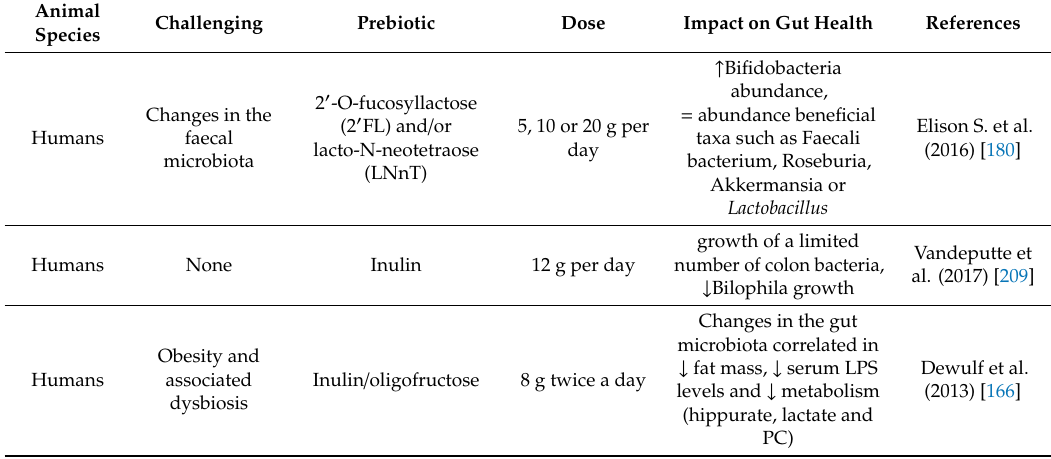
Table 2. Impact of prebiotics on gastrointestinal health: main experimental